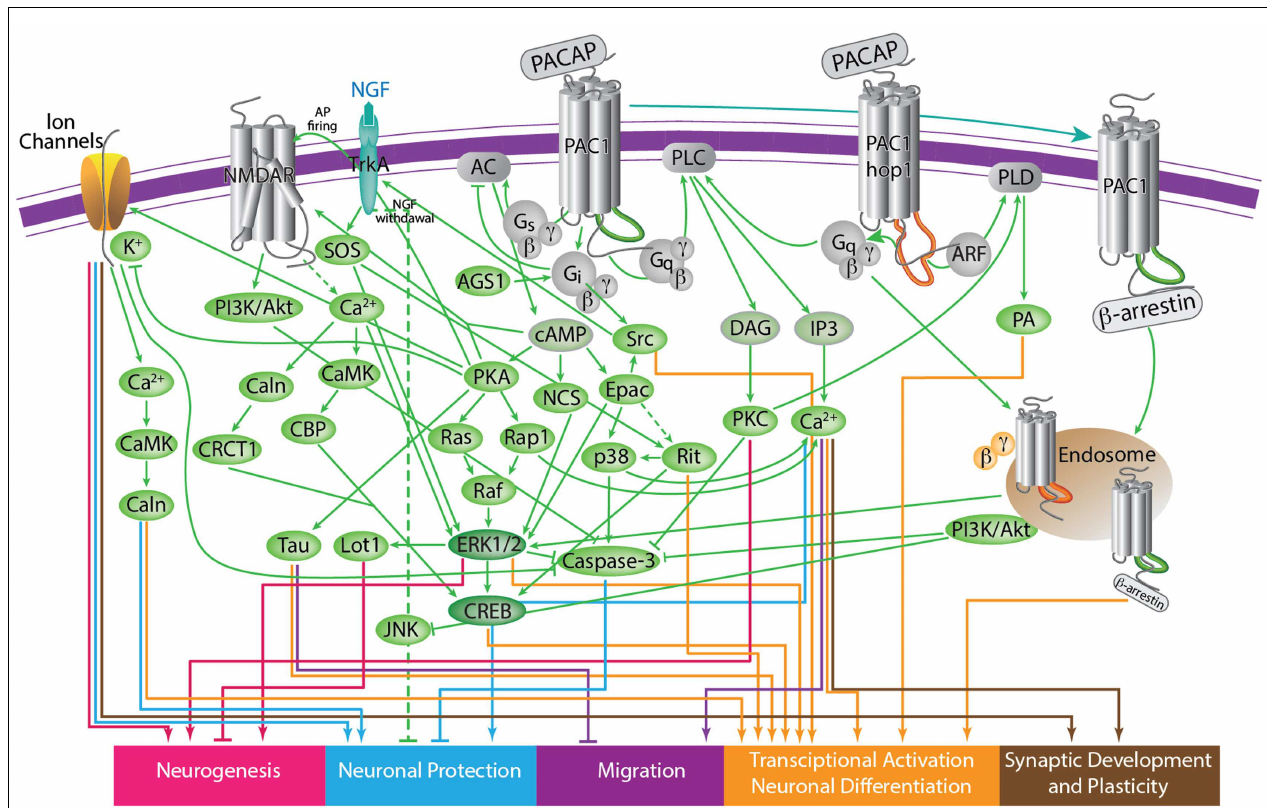
FIGURE 4 |A scheme depicting the current knowledge on PAC1-mediated signaling cascades resulting in a variety of neuronal outcomes . PKA was shown to induce ERK1/2 thereby contributing to PACAP neuroprotective (Villalba et al., 1997;Vaudry et al., 2003; Falluel-Morel et al., 2006;